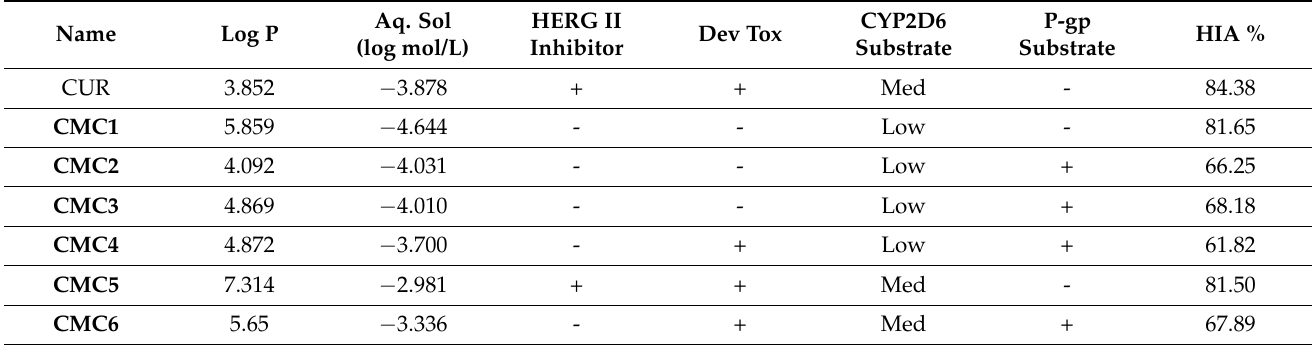
Table 3. Predicted ADME properties of CMC